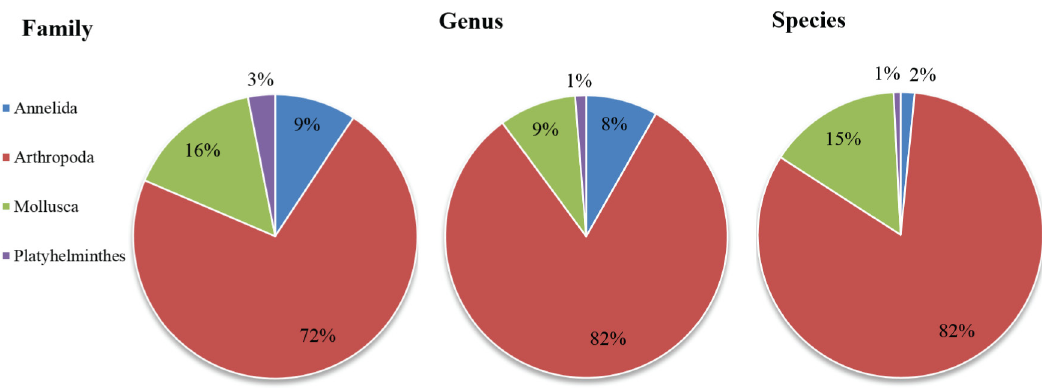
Figure 3. Macroinvertebrate recorded in the Iranian running waters, showing the species, genus and family composition; a total of 4 phyla encompassing 126 species, 158 genus, 97 family, 25 order and 7 classes identified from the meta-data extracted from 57 articles listed in Table 1 and Figure